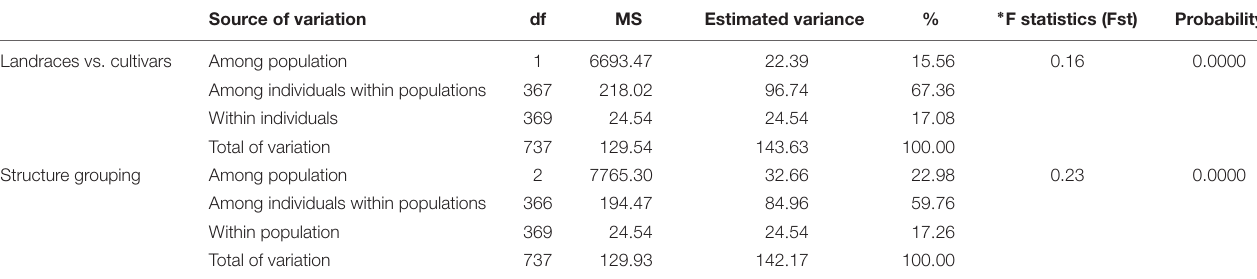
Source of variation df MS Estimated variance